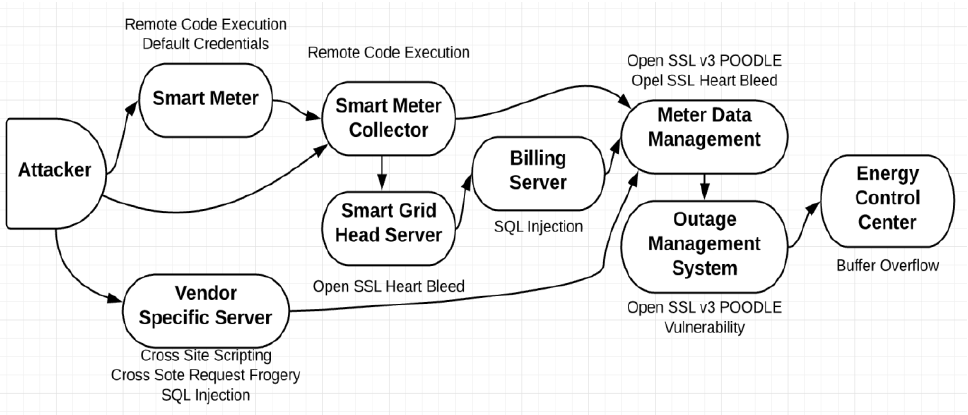
Figure 7. Vulnerability Bayesian network: test network.